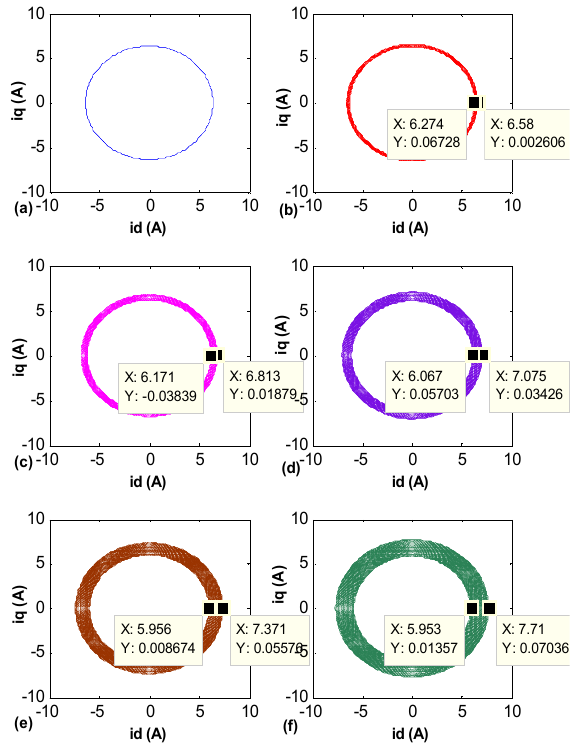
Table 5. The thickness of the Park’s vector pattern of a motor at nominal load and under different degrees of rotor fault conditions.